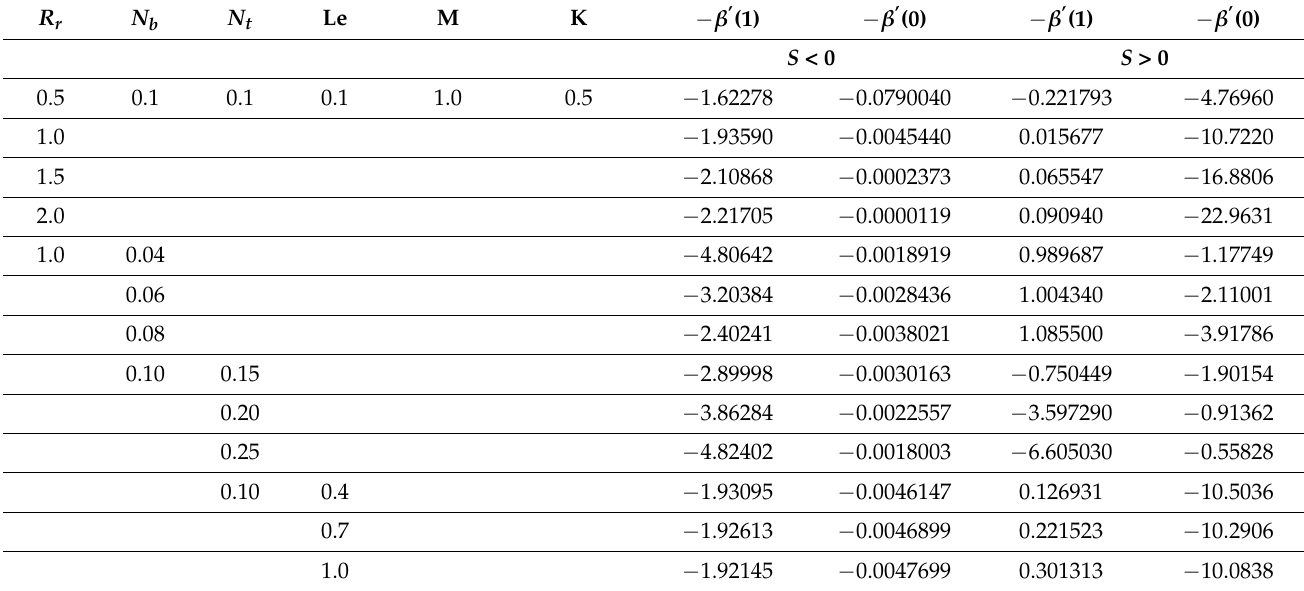
Table 13. Local Sherwood number for γ Al 2 O 3 − C 2 H 6 O 2 at lower and upper plane with weak interaction n =